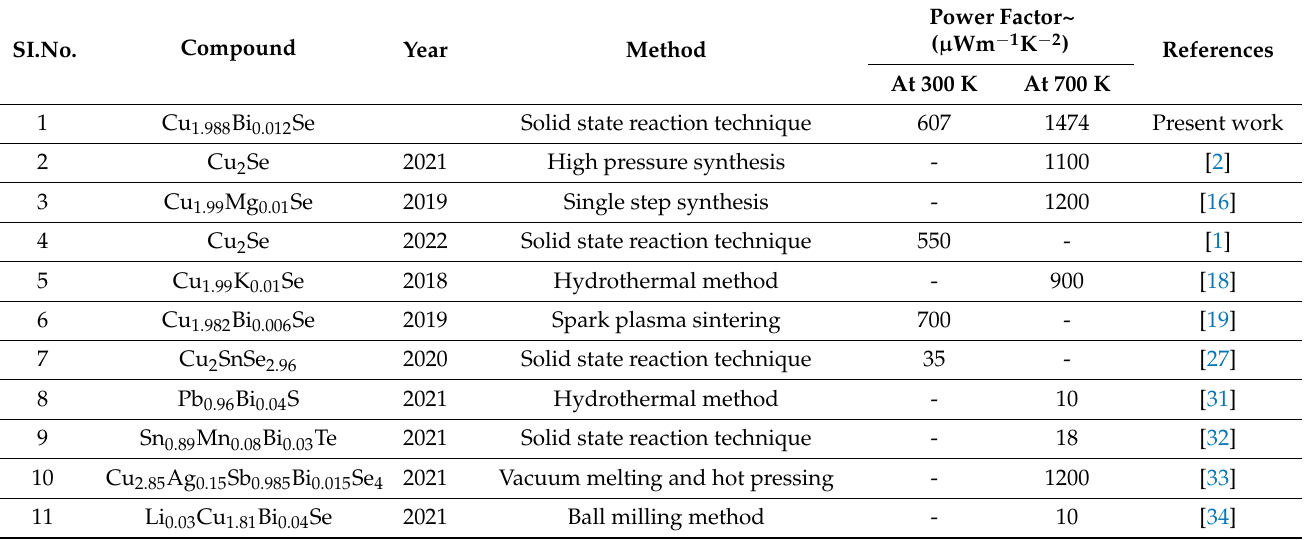
Table 7. Comparing the power factor of various